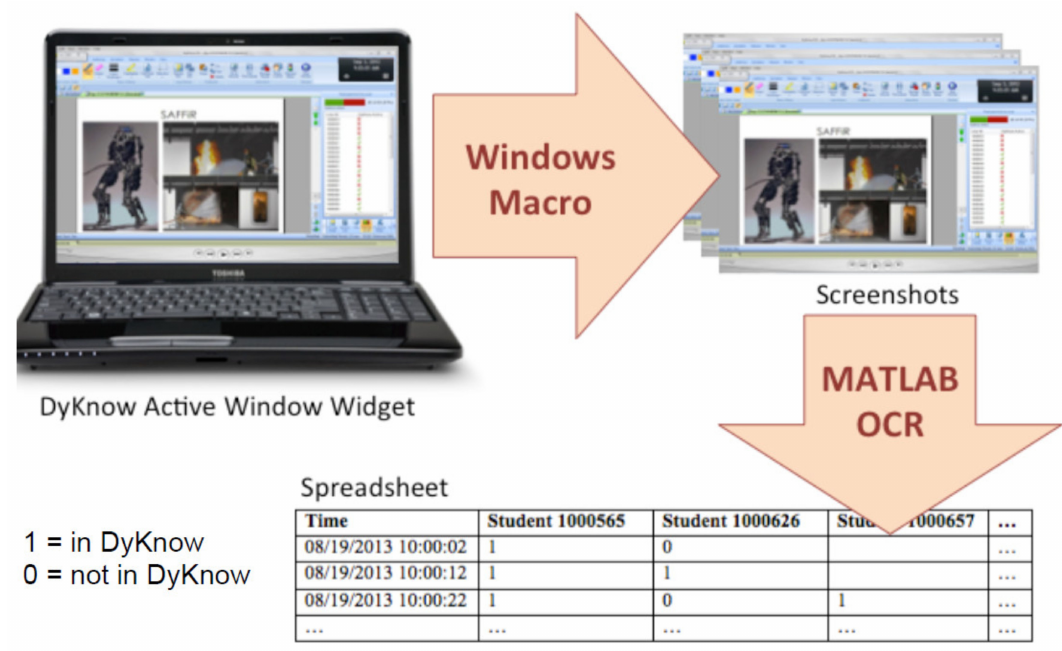
Figure 3. Processing of the